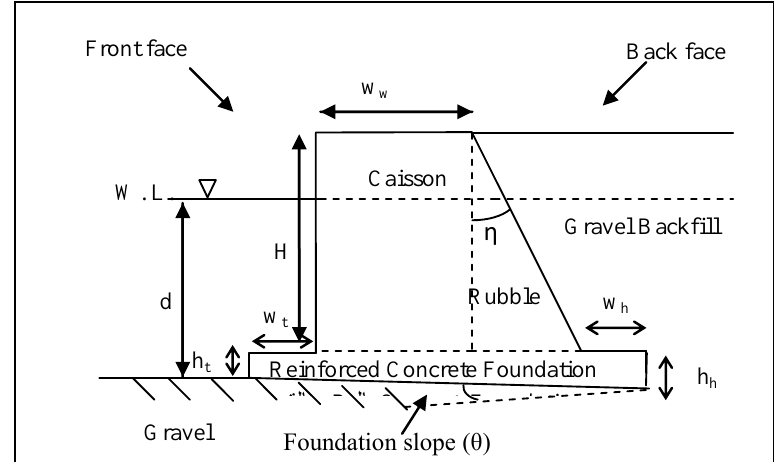
Fig. 1. Cross section of a typical quay wall.